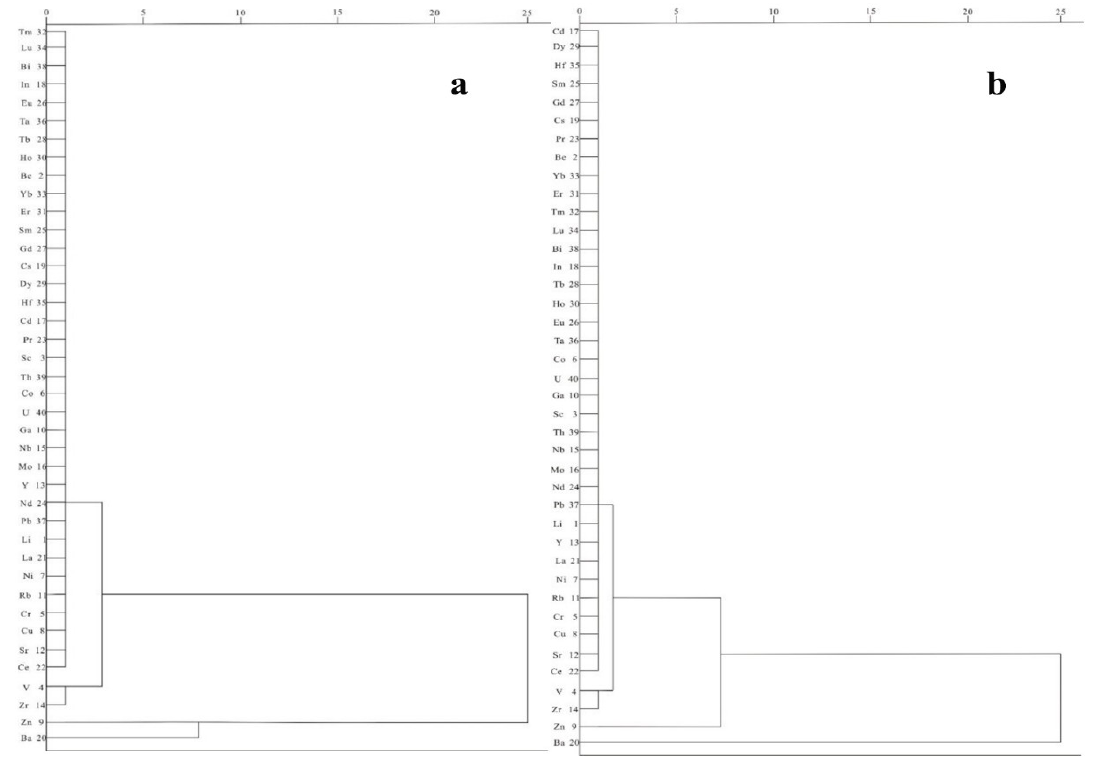
Figure 8. Pedigree diagram of element clustering in samples E ( a ) and E 1 ( b ). Table 7. Comparison table of content changes in samples E and E 1 (ppm).